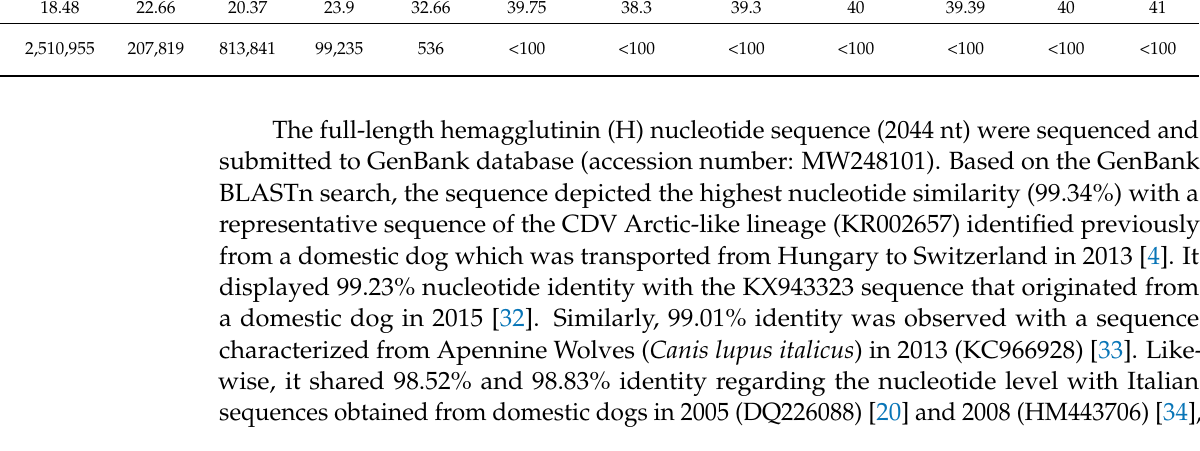
cRNA ( n copies/ µ